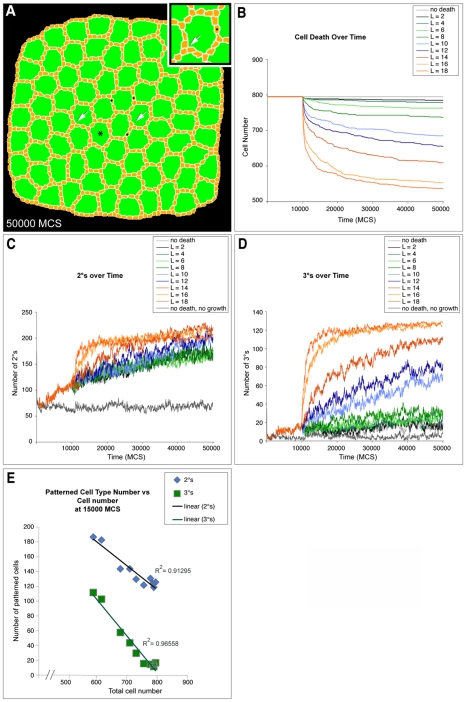
Secondary and tertiary formation depends on cell death.(A) Image captured at 50,000 MCS from a simulation of reduced cell death (L = 12) showed numerous ectopic, end-to-end 2°-like cells (•) and vertices with three cells in the 3° locus (arrows). Asterisk labels an ommatidium enlarged in inset. (B) Graph showing the decrease in cell number over time for different levels of cell death. L controlled the ‘strength’ of cell death as described in Results. Cell death was initiated at 10,000 MCS and each line represents the result of a single representative simulation from at least two repetitions. (C) Graph showing formation of 2°s over time for different levels of cell death. Each line represents the result of a single representative simulation from at least two repetitions. (D) Graph showing formation of 3°s over time for different levels of cell death. Each line represents the result of a single representative simulation from at least two repetitions. (E) Graph showing number of both 2° and 3°s at 15,000 MCS as cell death parameters are changed to increase the total cell number. Each point represents a different cell death parameter in the simulations from (B), (C) and (D).